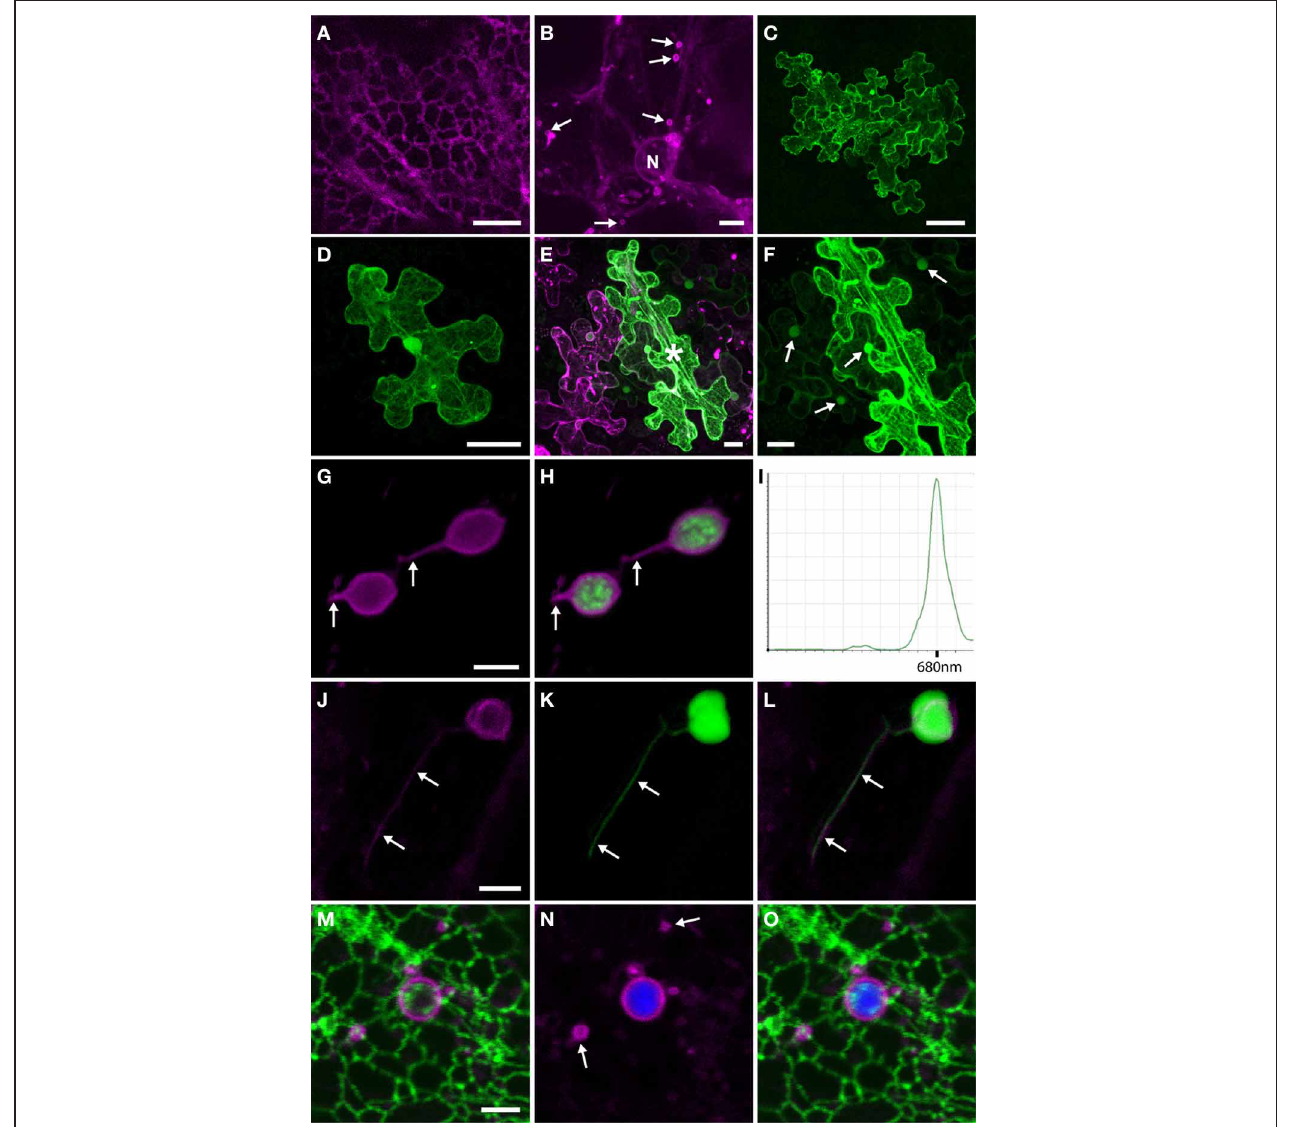
cells of N. benthamiana . Red fluorescence (magenta) is localized to the chloroplast envelope. Stromules are arrowed. Chlorophyll autofluorescence is shown in green in (H) . Bar in G = 4 μ m for (G and H) . (I) The emission spectrum of the contents of a 4 μ m diameter vesicle labeled with mRFP-TGB2 shows a peak at 680nm (emission range shown is from 495 to 755nm). (J,K,L) Co-expression of 35S::mRFP-TGB2 (magenta; J ) with GFP-AAT (green; K ) in a chloroplast in an epidermal cell of N. benthamiana . TGB2 is present in the membrane of the chloroplast and the stromule (J) , while GFP is visible throughout the stroma of both plastid and stromule (K) . The stromule is arrowed in each image and (L) shows an overlay of the two channels. Bar in J = 4 μ m for (J–L) . (M,N,O) To ensure that the ER membrane was not contributing to the fluorescence seen on the chloroplast membrane, 35S::mRFP-TGB2 (magenta) was expressed in mGFP5-ER (green) transgenic N. benthamiana . The green ER does not surround the chloroplasts and the plastids sit internal to the cortical ER network. Strands of ER can be seen to cross the surface of the chloroplasts (M and O) . The membranes of both 2 μ m diameter vesicles (arrows) and a 4 μ m diameter chloroplast are labeled with mRFP-TGB2 (M–O) , with the chlorophyll autofluorescence from the interior of the plastid shown in blue (N and O) . Bar in M = 4 μ m for (M–O)